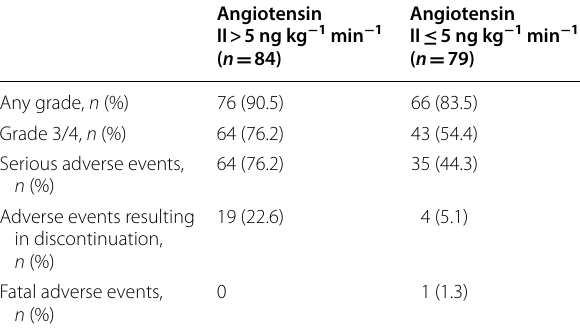
Table 4 Summary of treatment-emergent adverse events (regardless of causality) in either dosing